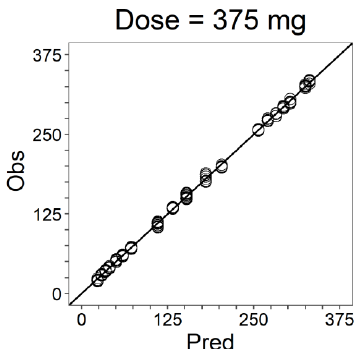
Figure A7. Goodness-of-fit plots for the in vitro release model for test batch (batch E) at 375 mg.